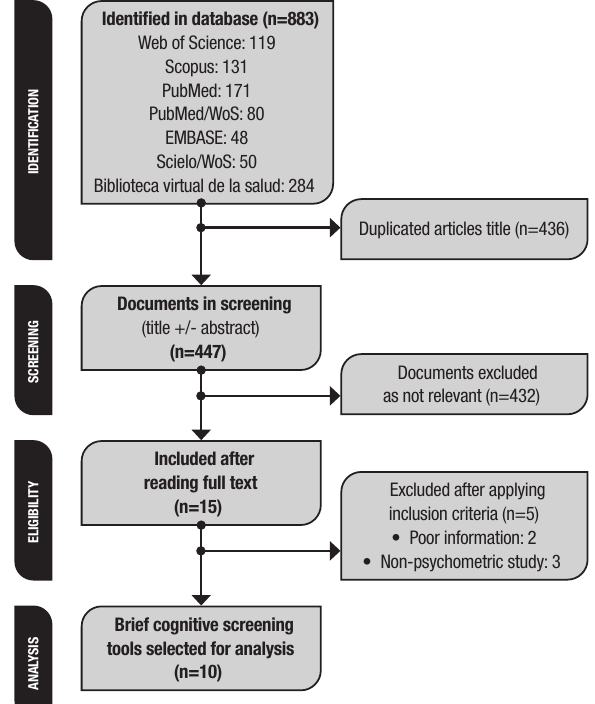
Figure 1. Flowchart of study selection